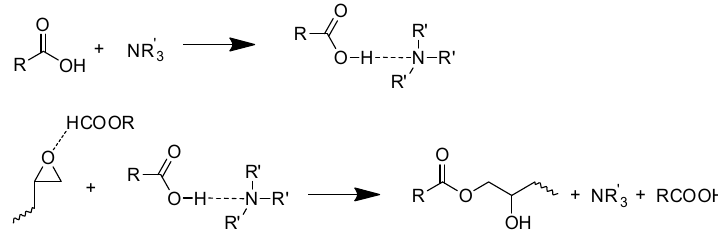
Table 3. Computed classical energy barriers for transition states and products via different reaction pathways at 0 K. Pathway − 46 Table 4. Transition states involved in proposed mechanisms. TS_i: <O1-C1-C2 = 88.42, C2-O2 = 2.286, ν (i, cm − 1 ) = −